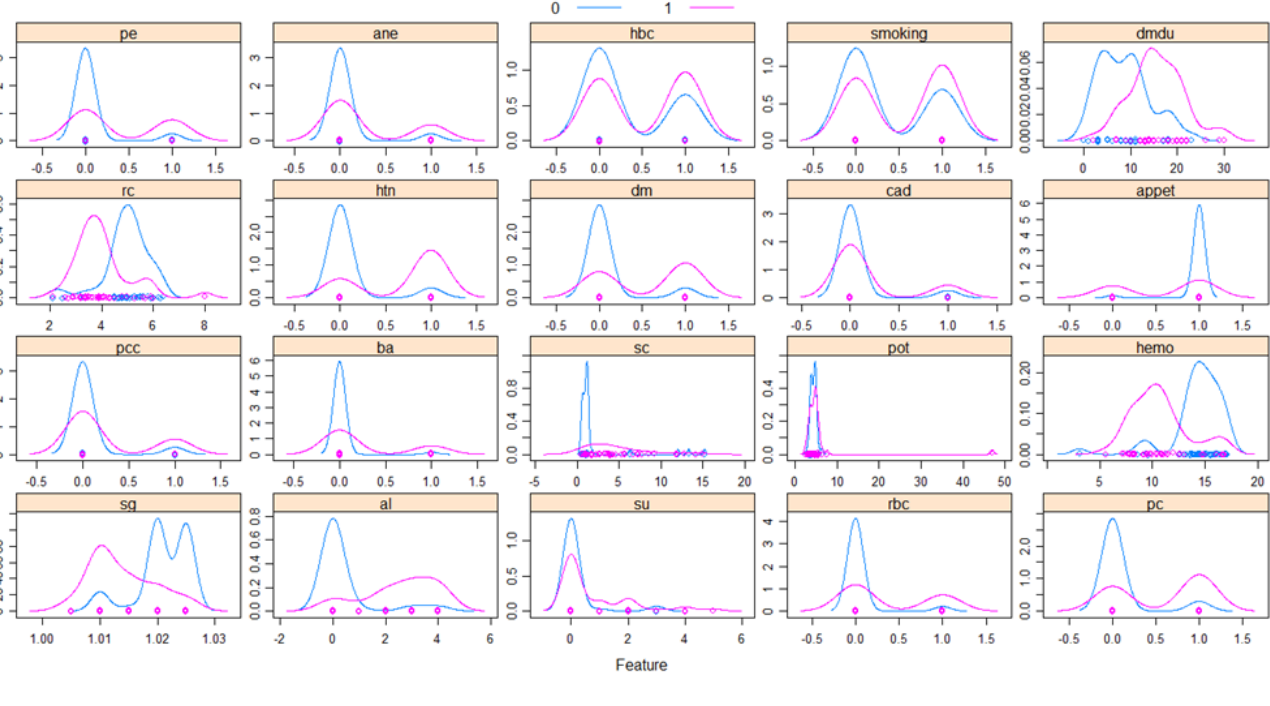
Figure 5 represents the density plot for each predictor variable by class of target variable. Density plot means distribution of variable. In this plot blue line is a class which